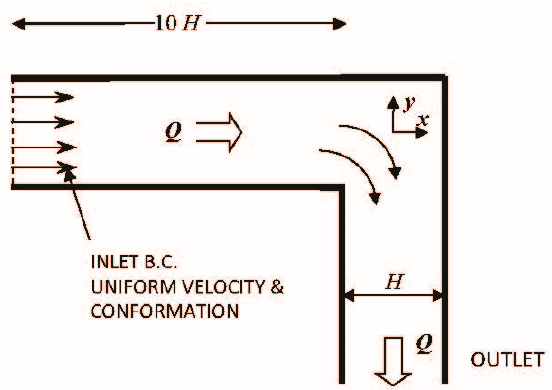
Figure 1. Computational domain, right-angle bend geometry. Q, volumetric flow rate; H, channel height; inlet/outlet branches length is 10 times H.